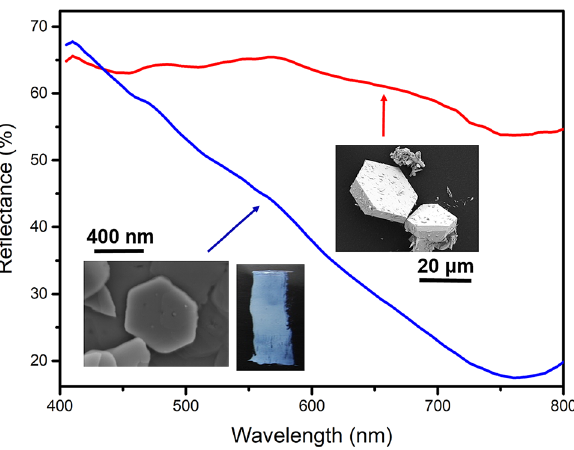
Figure 6. Reflectance spectra of two lead white layers (thickness of 60 µm) com-posed respectively of sub-micrometric (< 400 nm) and large (> 20 µm) HC crystallites. The sub-micrometric pigment exhibits a pronounced decrease of reflectance toward the red region of the visible range, whereas the pigment composed of large crystallites exhibits a nearly constant and high reflectance on the entire visible range. The insets represent the images of HC grains, and the blue hue of the film composed of the finer